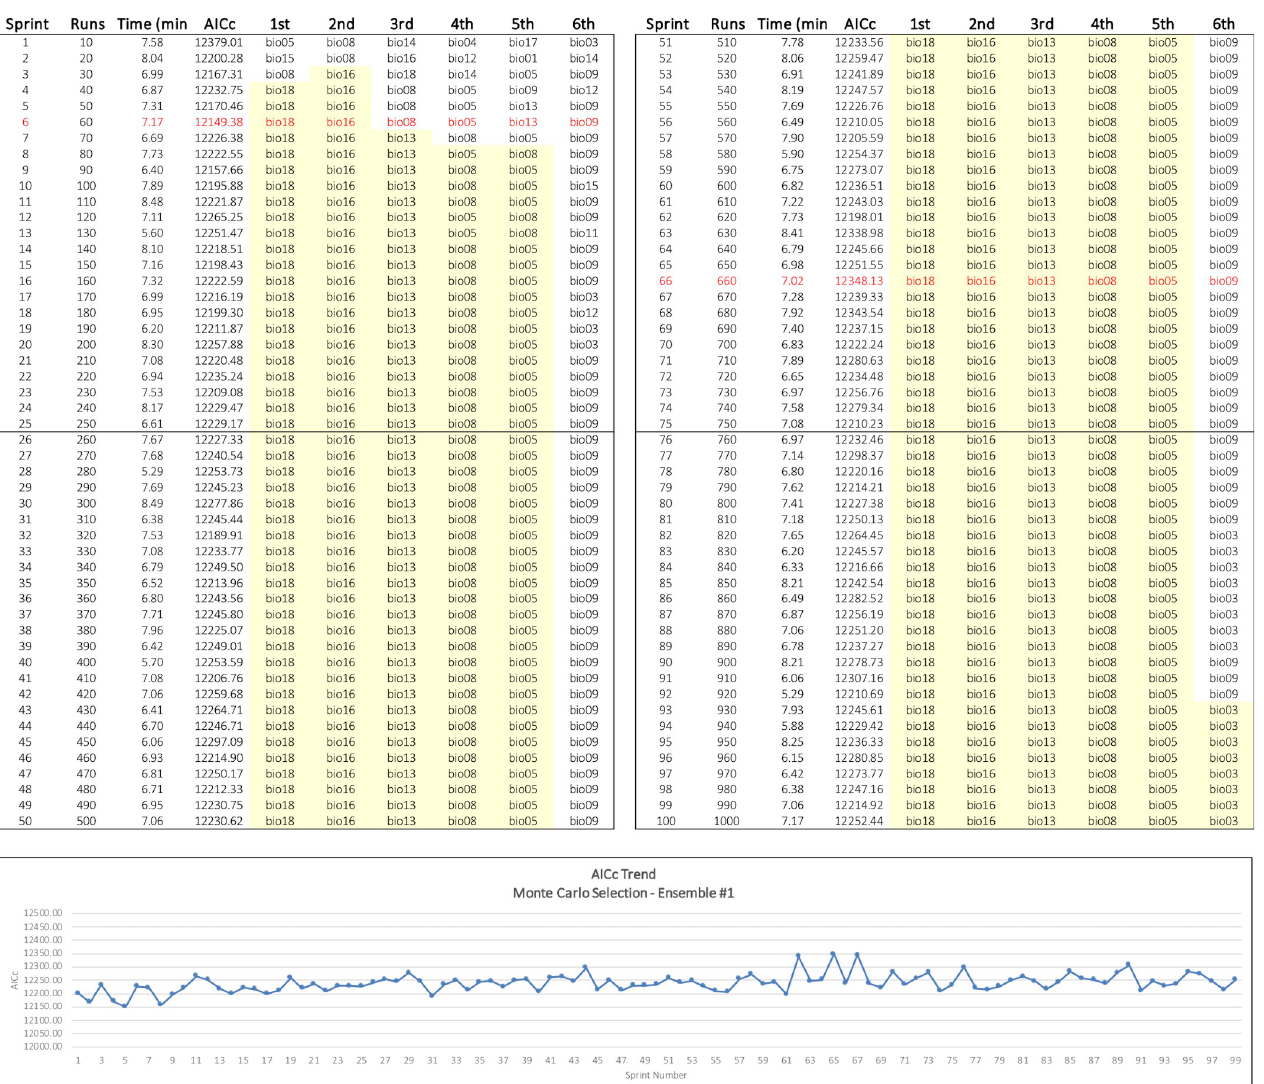
Fig 2. Monte Carlo Ensemble #1 results. Two random variables at a time were chosen for each MaxEnt sprint run. The sprint log on top shows the progressive selection of a stable set of top six variables in yellow. The graph on the bottom shows the narrow range of fluctuating AICc values over the course of the ensemble runs. Maximum and minimum AICc values are shown in